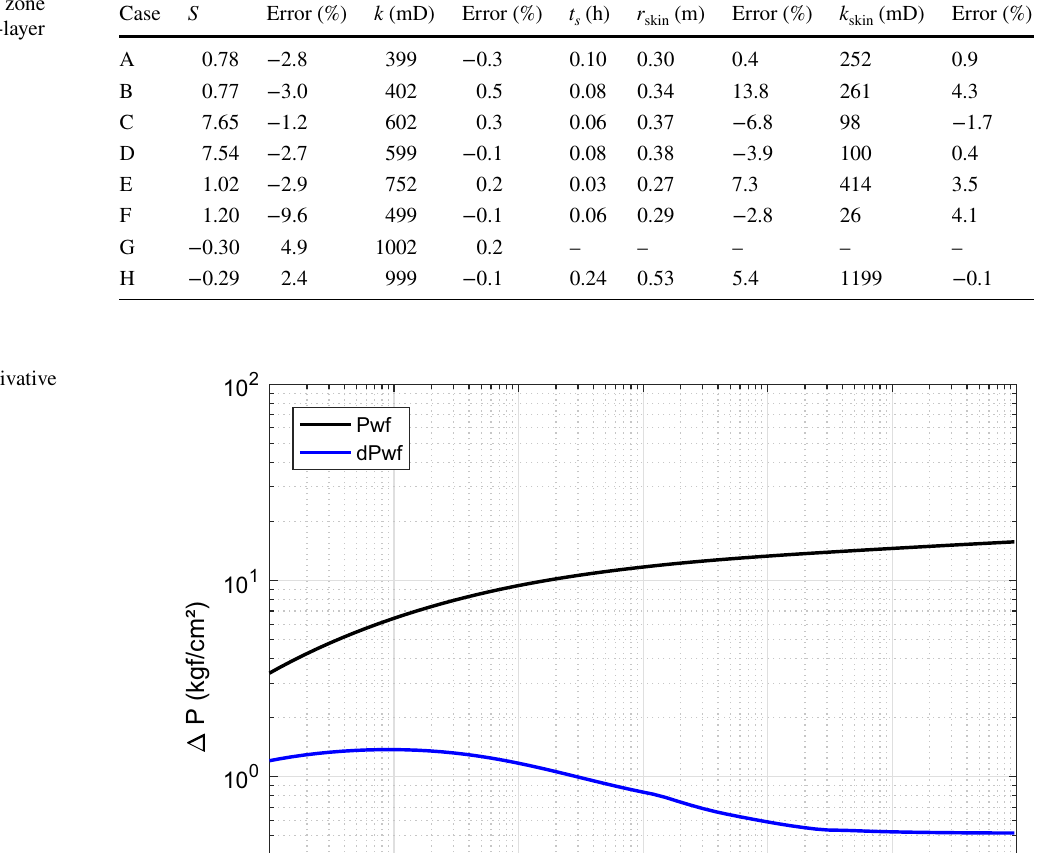
Table 2 Estimated skin zone properties of the single-layer cases